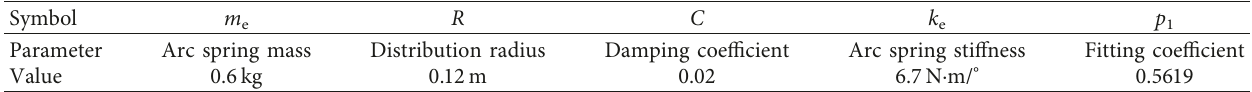
Table 3: Known parameters.